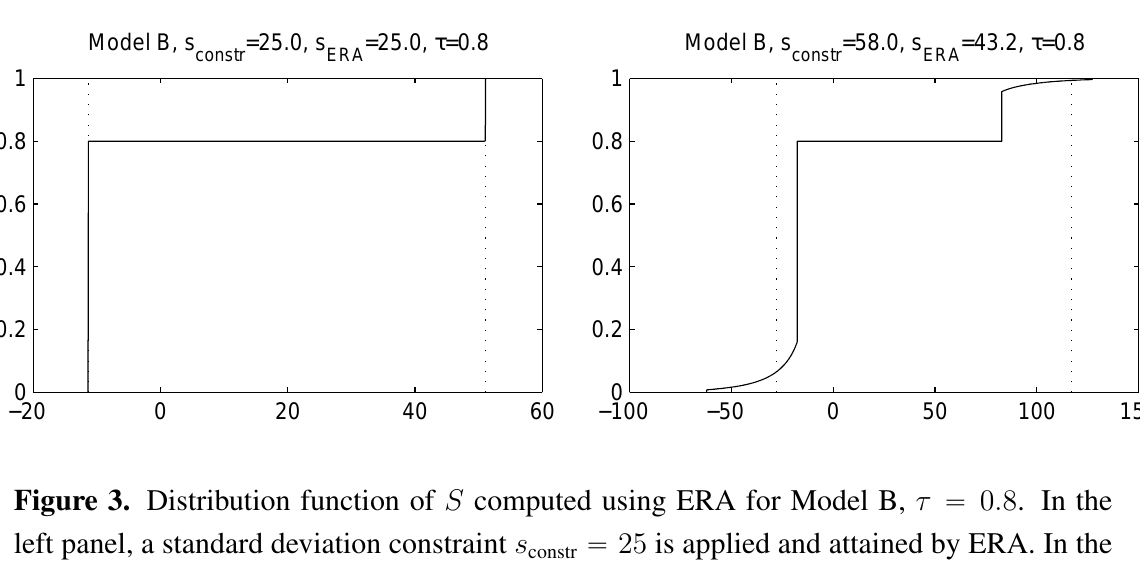
Figure 2. Moment space upper bound B on the expectile, and an approximation of e s 2 computed using the extended rearrangement algorithm (ERA), as a function of the standard deviation constraint s on the horizontal axis. The unconstrained expectile bounds are also plotted for the sake of comparison. The dotted vertical line is the maximum standard deviation of a diatomic random variable, which is consistent with the marginal upper- and lower-tail expectations.